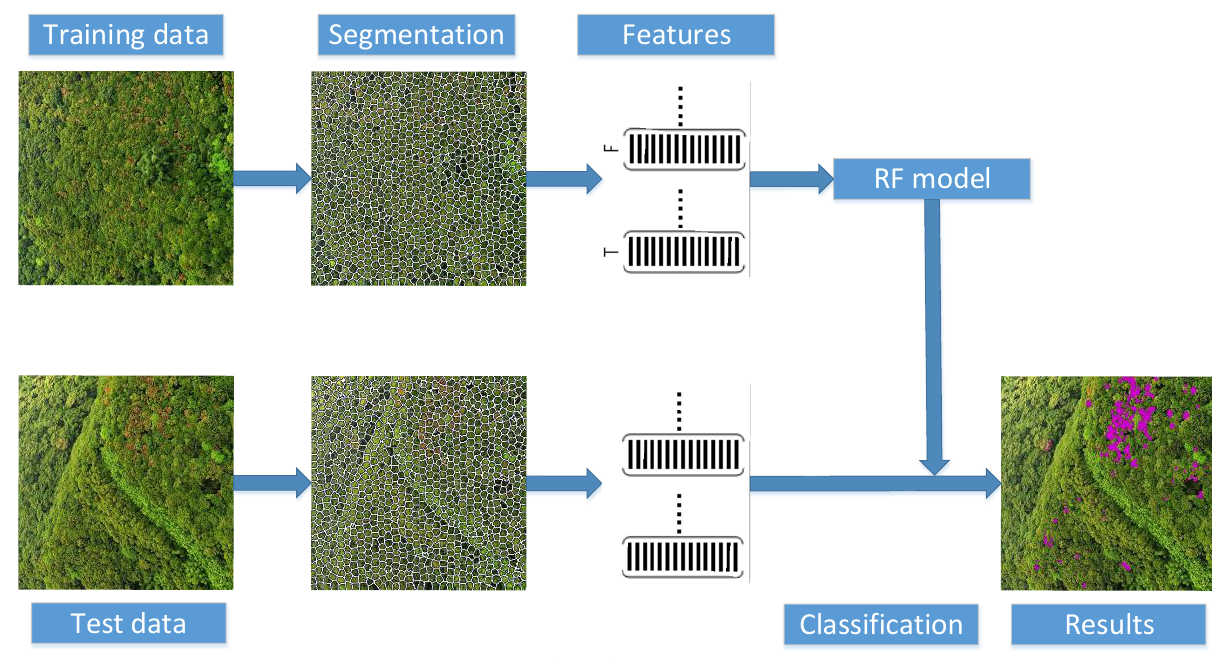
Figure 1. Workflow of the proposed